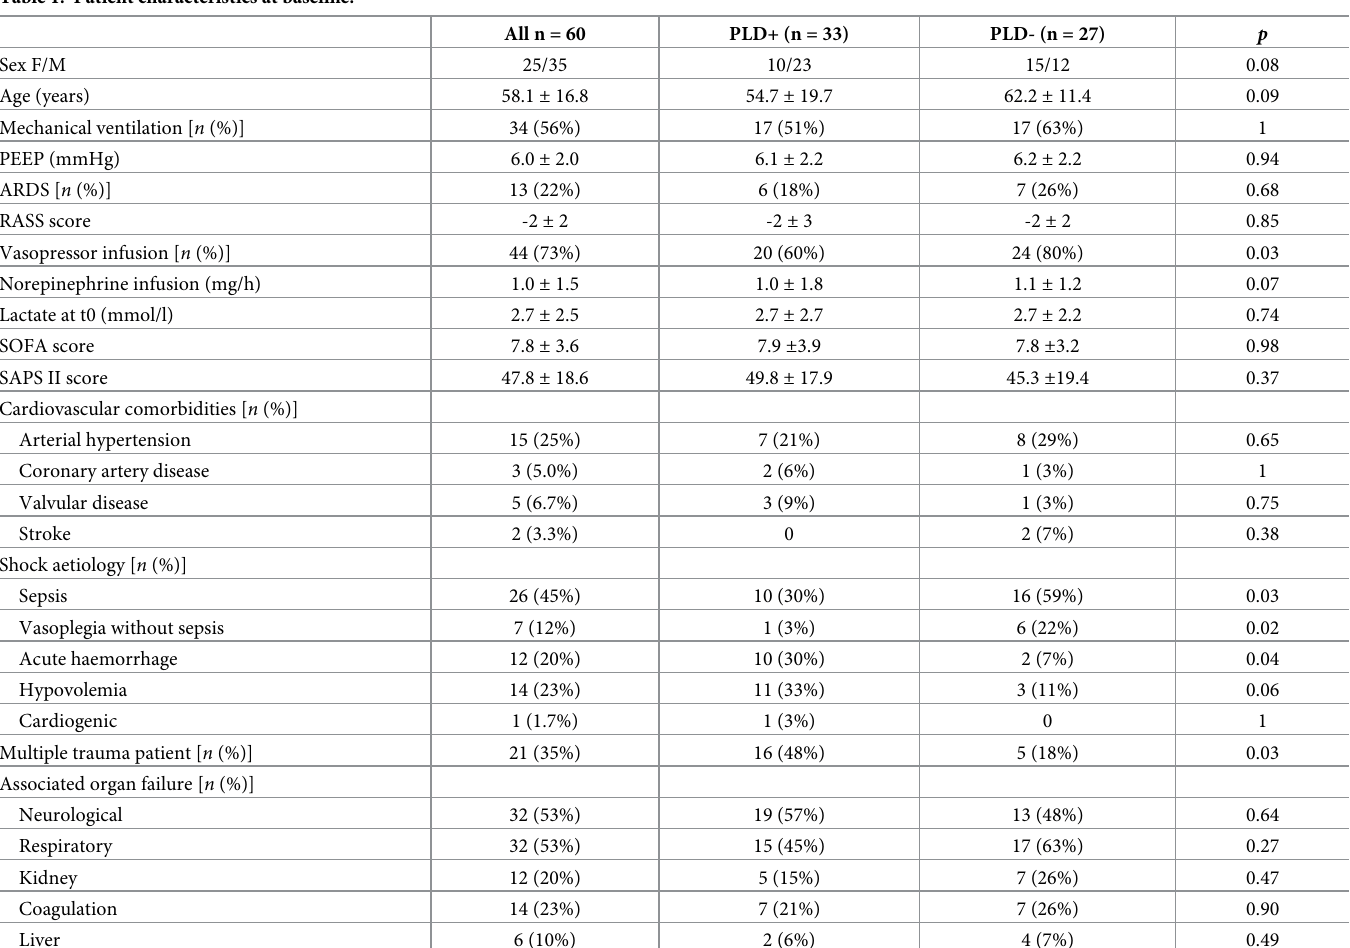
Table 1. Patient characteristics at